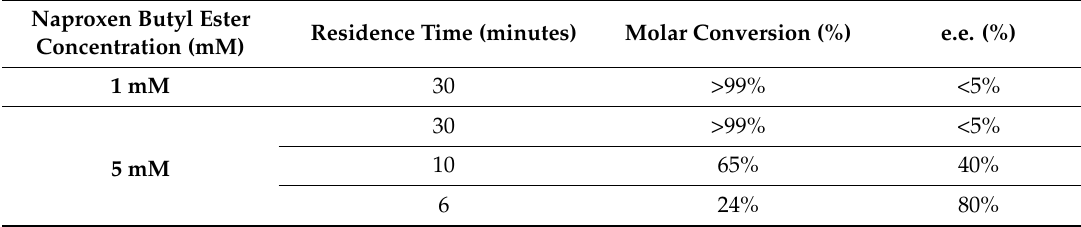
Table 2. Flow assisted hydrolysis of naproxen butyl ester. The substrate was prepared in 50